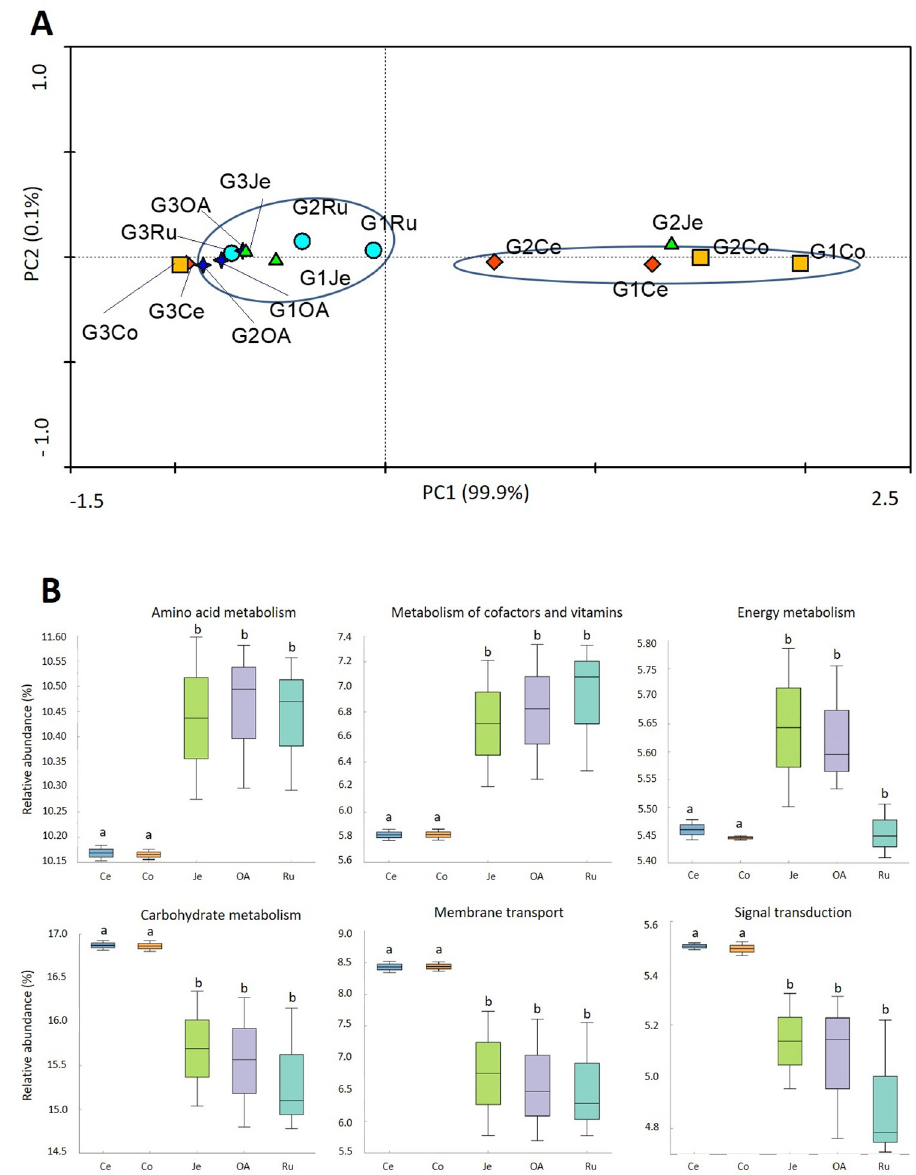
Fig 7. (A) Samples distribution based on the archaeal functional diversity at Level 2 KEGG present in the Capra hircus GITs. (B) Comparison of the six most abundant archaeal gene families with significant differences (p < 0.05) among rumen (Ru), omasum-abomasum (OA), jejune (Je), cecum (Ce) and colon (Co) archaeal communities. Different superscripts were significantly different (P <